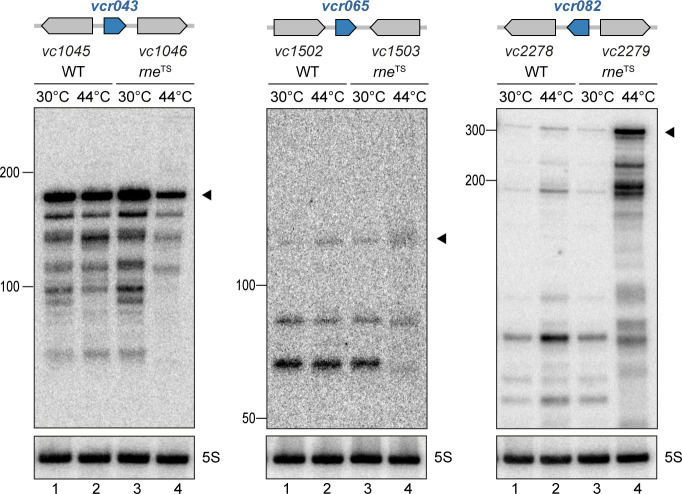
RNase E-mediated maturation of sRNAs from IGRs.V. cholerae wild-type and rneTS strains were grown at 30°C to stationary phase (OD600 of 2.0). Cultures were divided in half and continuously grown at either 30°C or 44°C for 30 min. Cleavage patterns of intergenic sRNAs were monitored on Northern blots. The genomic locations and relative orientations are shown above the gels. Genes are shown in gray; sRNAs are shown in blue. Filled triangles indicate the size of unprocessed sRNAs. 5S rRNA served as loading control.Figure 1—figure supplement 5—source data 1.Full Northern blot images for the corresponding detail sections shown in Figure 1—figure supplement 5.